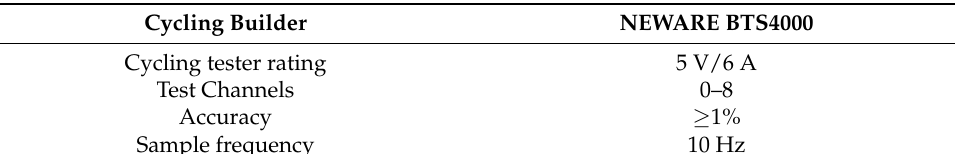
Table 2. Neware battery tester BTS4000 equipment specification.